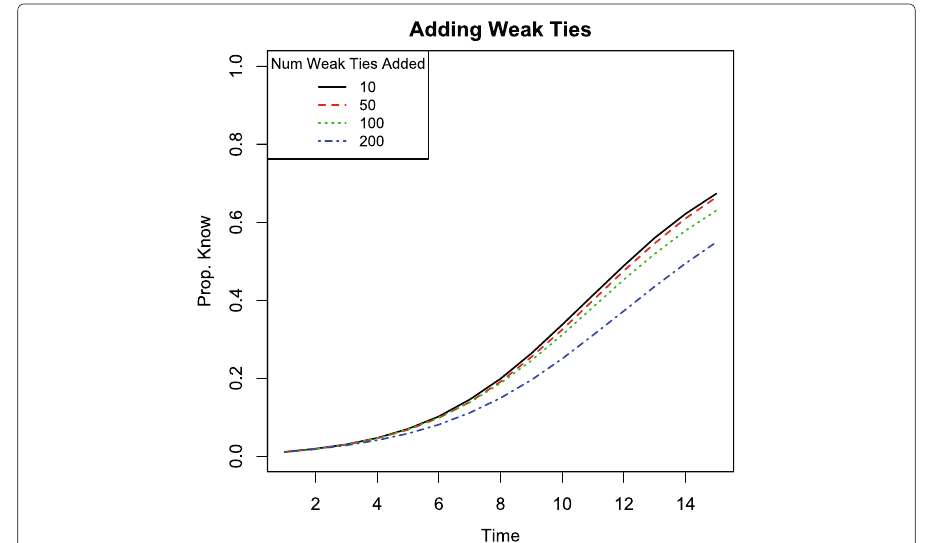
Fig. 4 Proportion of network informed by each timestep in simulated information spread in Mugana with new weak ties added to the network. Simulation parameters set to x = 2, p same = 1, and p weak = .4. Adding weak ties makes diffusion strictly